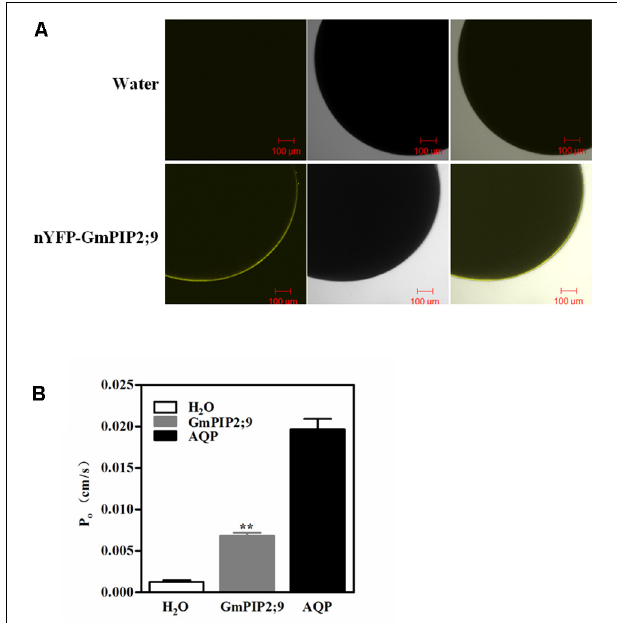
FIGURE 2 | Expression of functional GmPIP2;9 in Xenopus oocytes. (A) YFP localization of nYFP-GmPIP2;9 in Xenopus oocytes. The oocytes were observed 2 days after injection as described in Section “Methods.” Bars = 100 µ m. Fluorescence (left), bright-field (middle), and merged images (right) showing that nYFP-GmPIP2;9 fusion protein is expressed in plasma membrane of oocytes. (B) Oocytes were injected with 23 ng GmPIP2;9 cRNA or water. The osmotic water permeability coefficients ( P f ) of oocytes were determined from swelling kinetics. Data represent the mean ± SD measurements from 10 oocytes. ∗∗ P < 0.01.